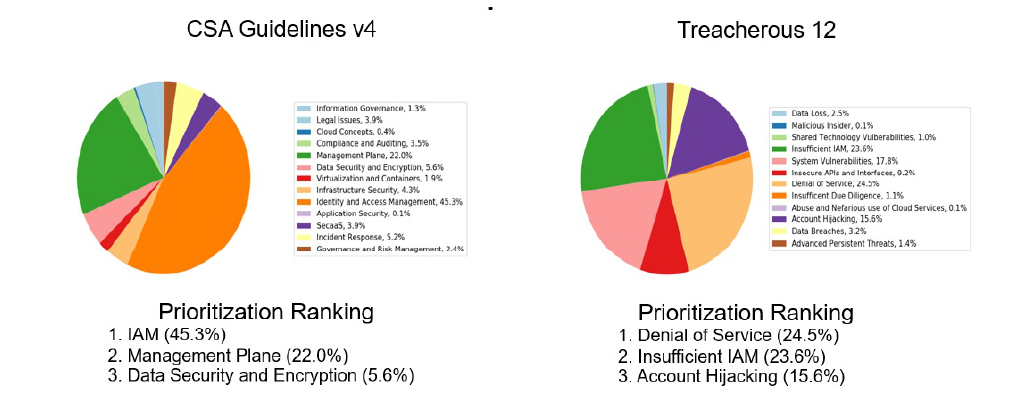
Figure 3. Threats towards Cloud Authentication.